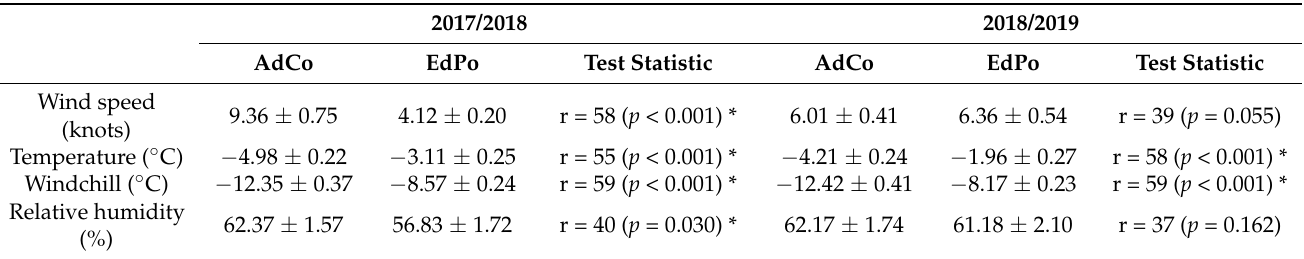
Table 2. Differences in mean daily measurements ( ± standard error) of weather parameters between colonies, for both study years. Weather parameters were averaged over 62 days (20 November– 20 January) and differences were tested through the paired sign test (the test statistic, r, is reported). An asterisk marks significant ( p < 0.05)